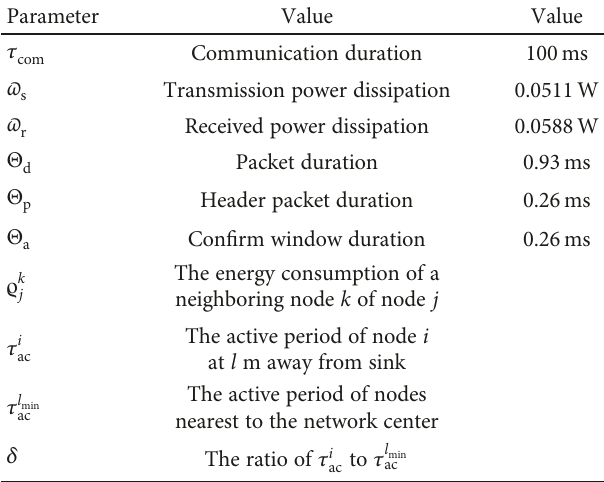
Table 1: Network